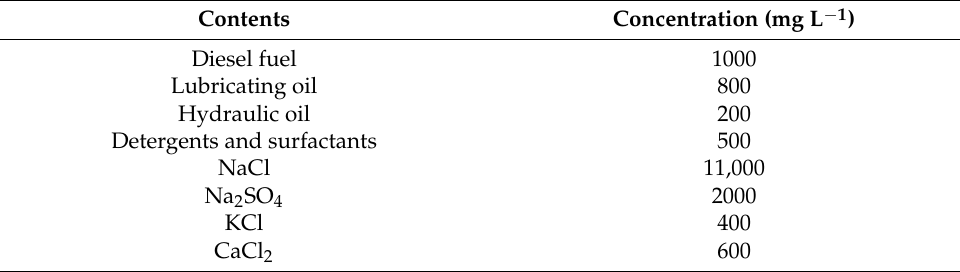
Table 2. The composition of synthetic bilge